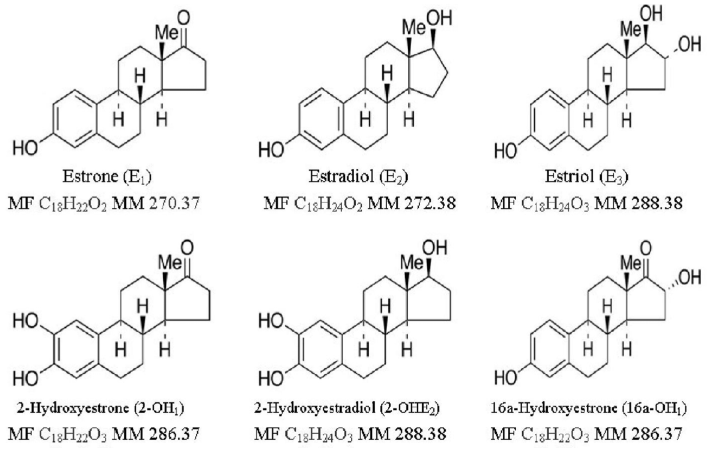
Figure 2. Chemical structure, molecular formula (MF), and molecular mass (MM) of the 6 estrogen